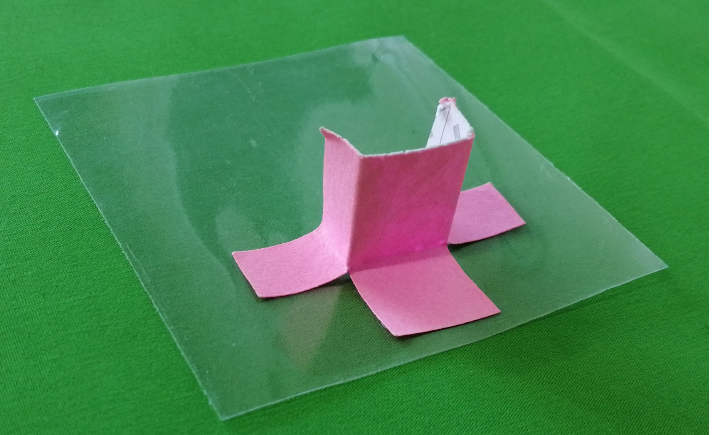
Figure 13. Slider with cardboard. The transparent sheet was the slider used in the work. The pink card- board was attached using tape to facilitate displacement measurement using a laser displacement sensor.